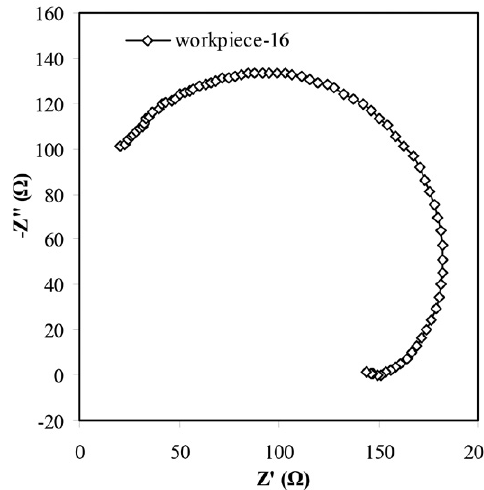
Figure 9. Nyquist plot of EIS results for workpiece 16.